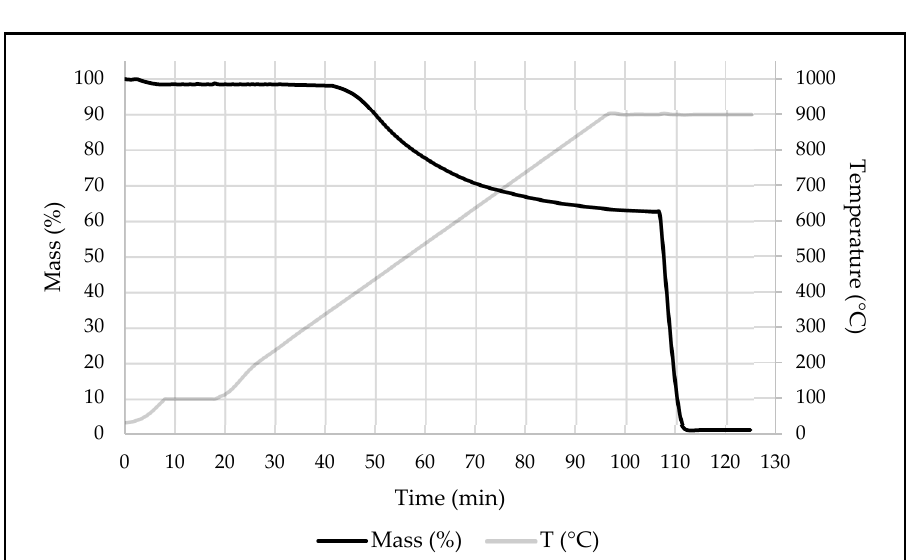
Figure 2. Thermogravimetric analysis of biochar, with the T program and mass loss.